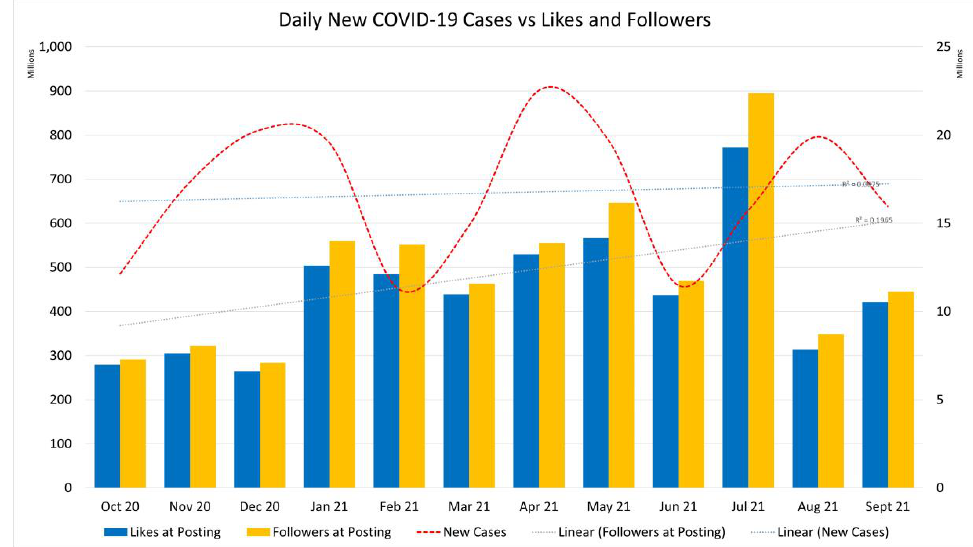
Figure 4 Figure 4. Daily new COVID-19 cases vs. likes and followers. Depiction of new cases, likes and followers at posting with trend